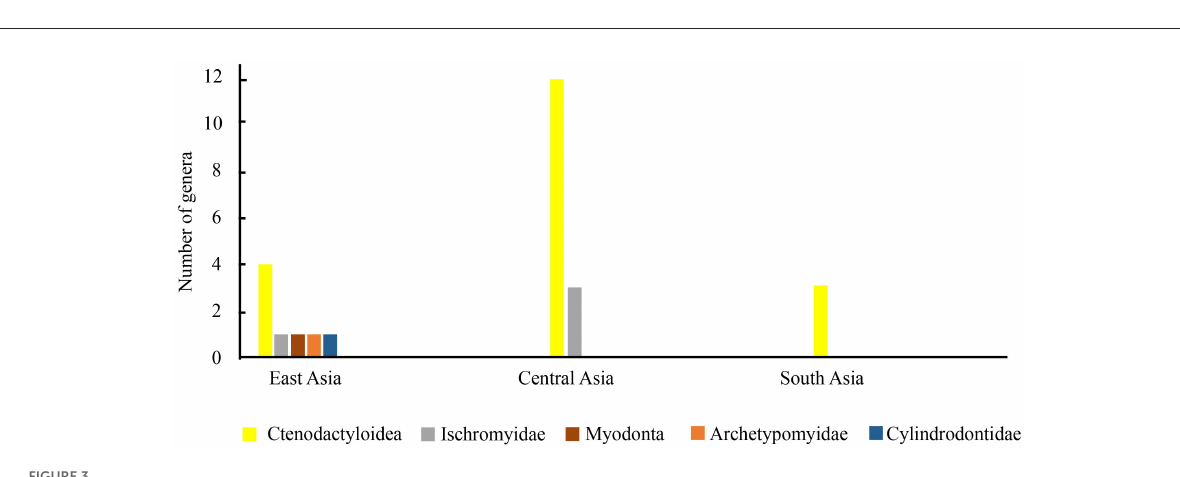
FIGURE3 Diagram of the Arshantan rodent compositions in East, Central, and South